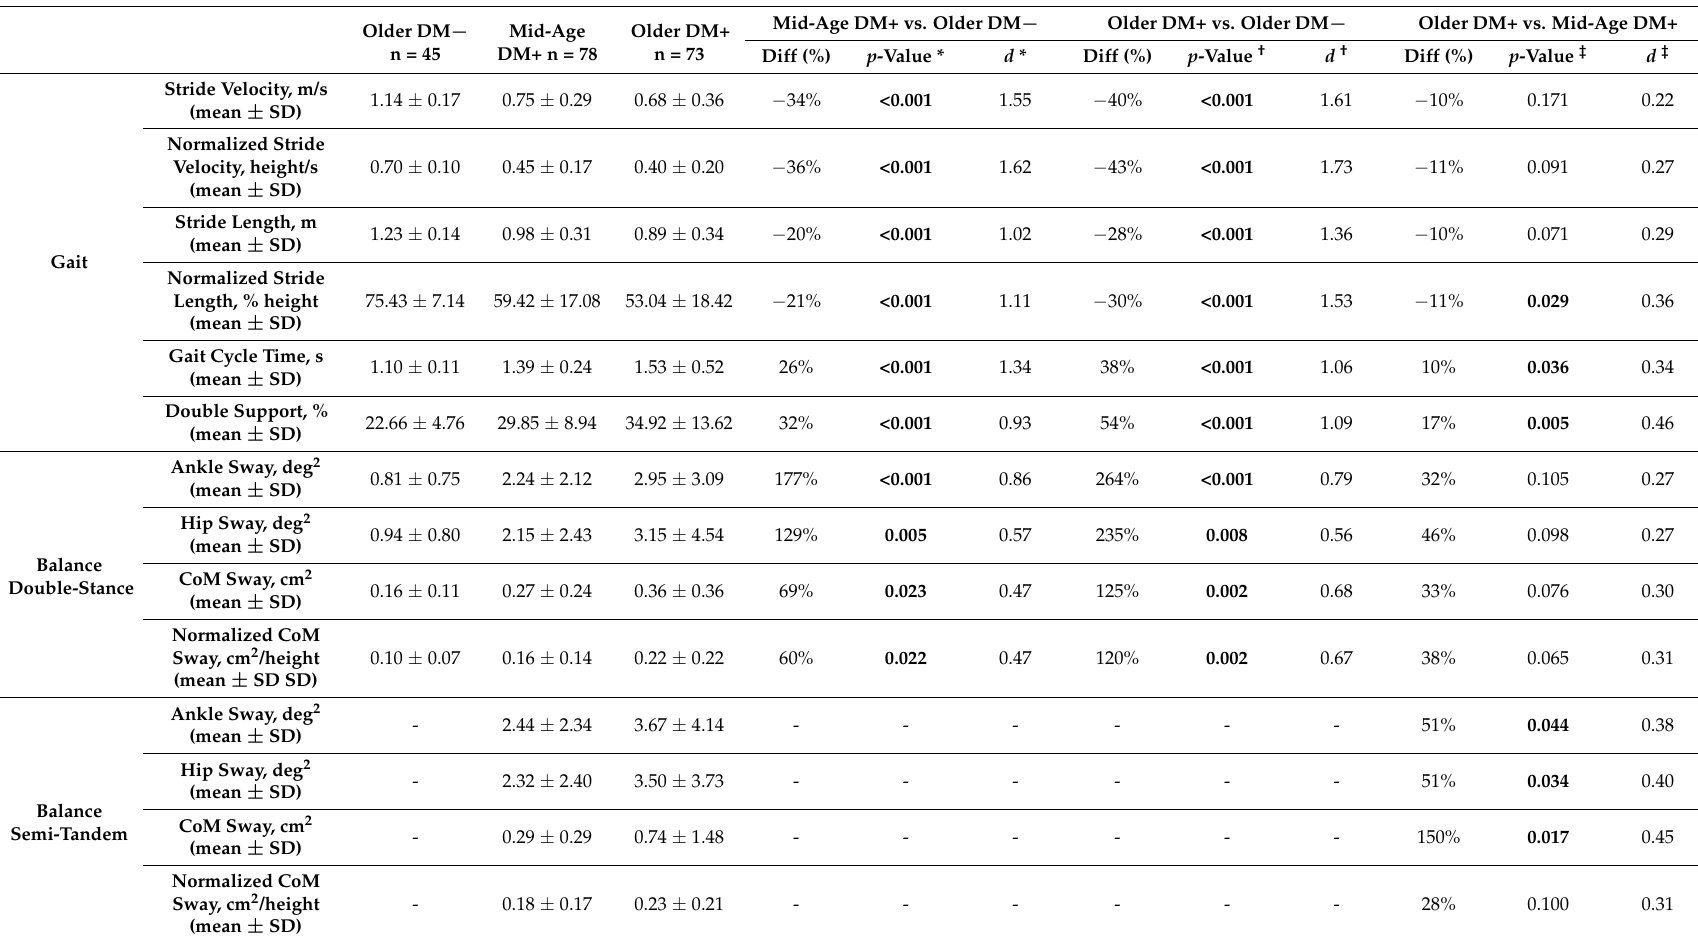
Table 2. Between-group comparison for gait and balance performance among Older DM − , Mid-age DM+, and Older DM+ groups.